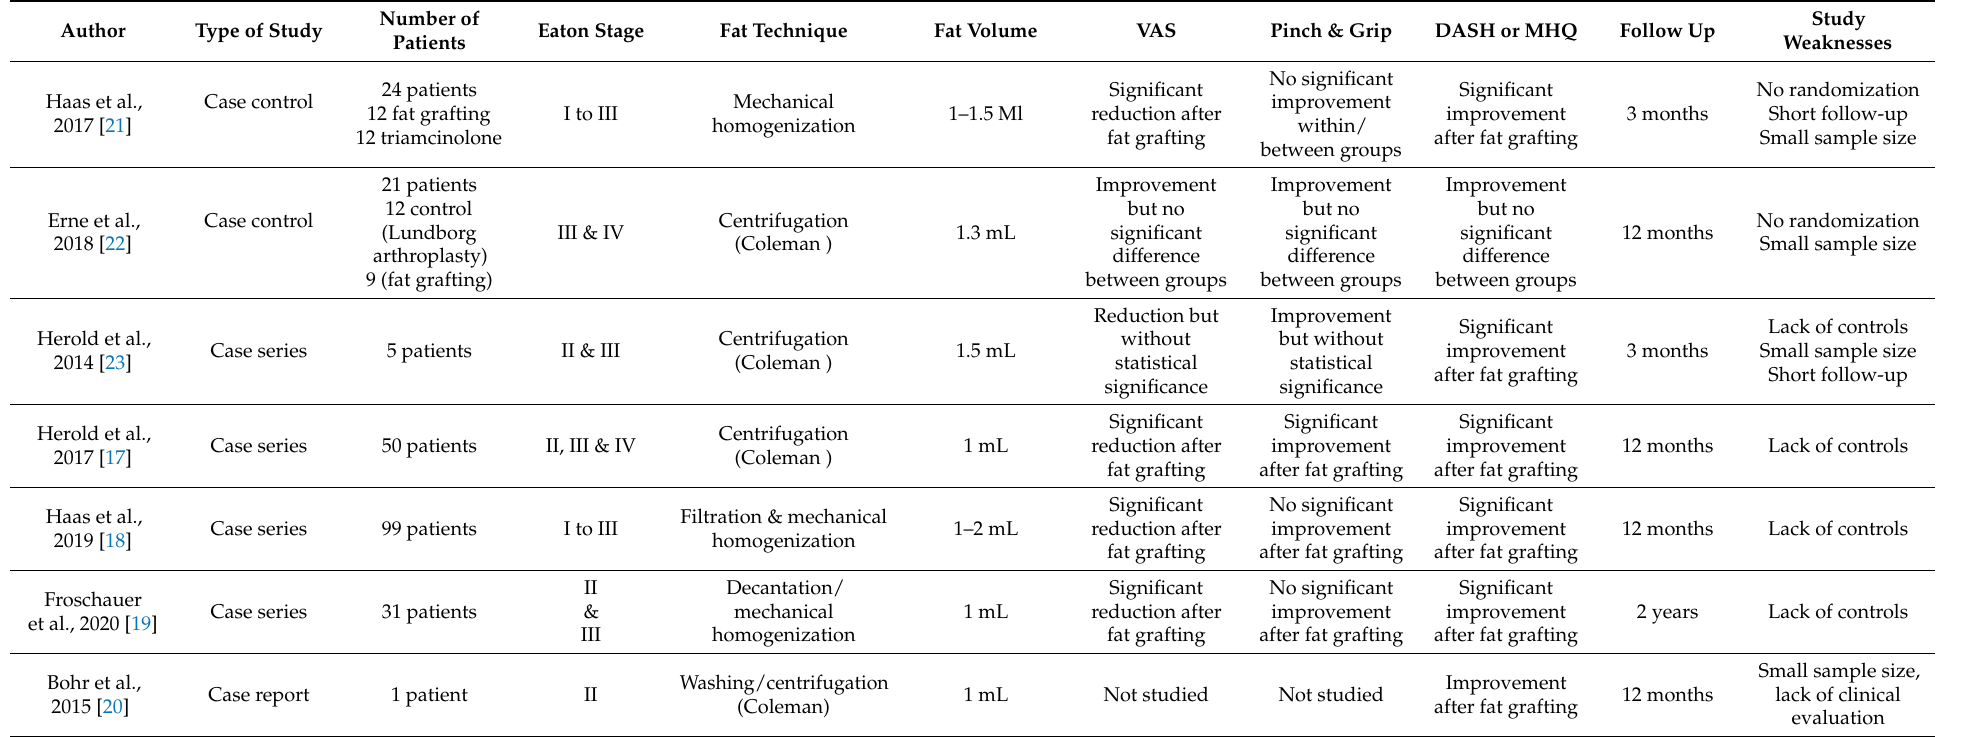
Table 1. Summary of findings of reviewed